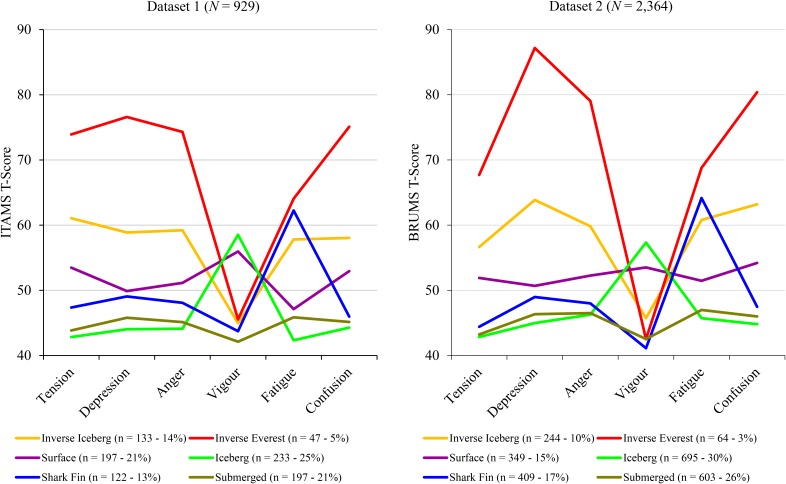
Graphical representation of the 6-cluster solution in two samples.